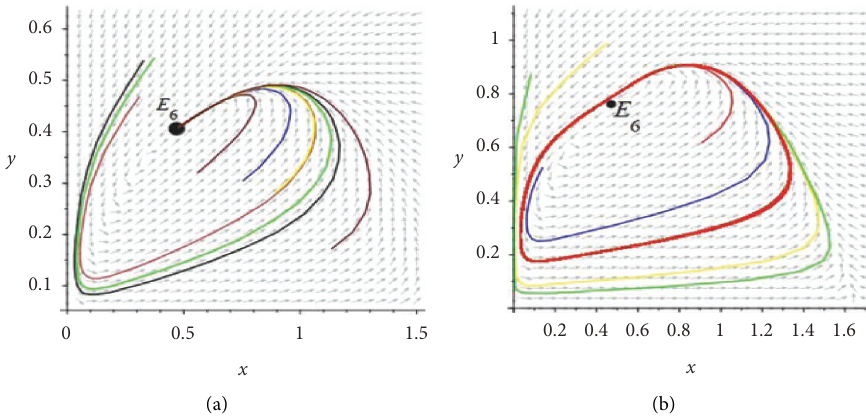
Figure 7: Phase diagrams in the case ( C 4): (a) Stable node E